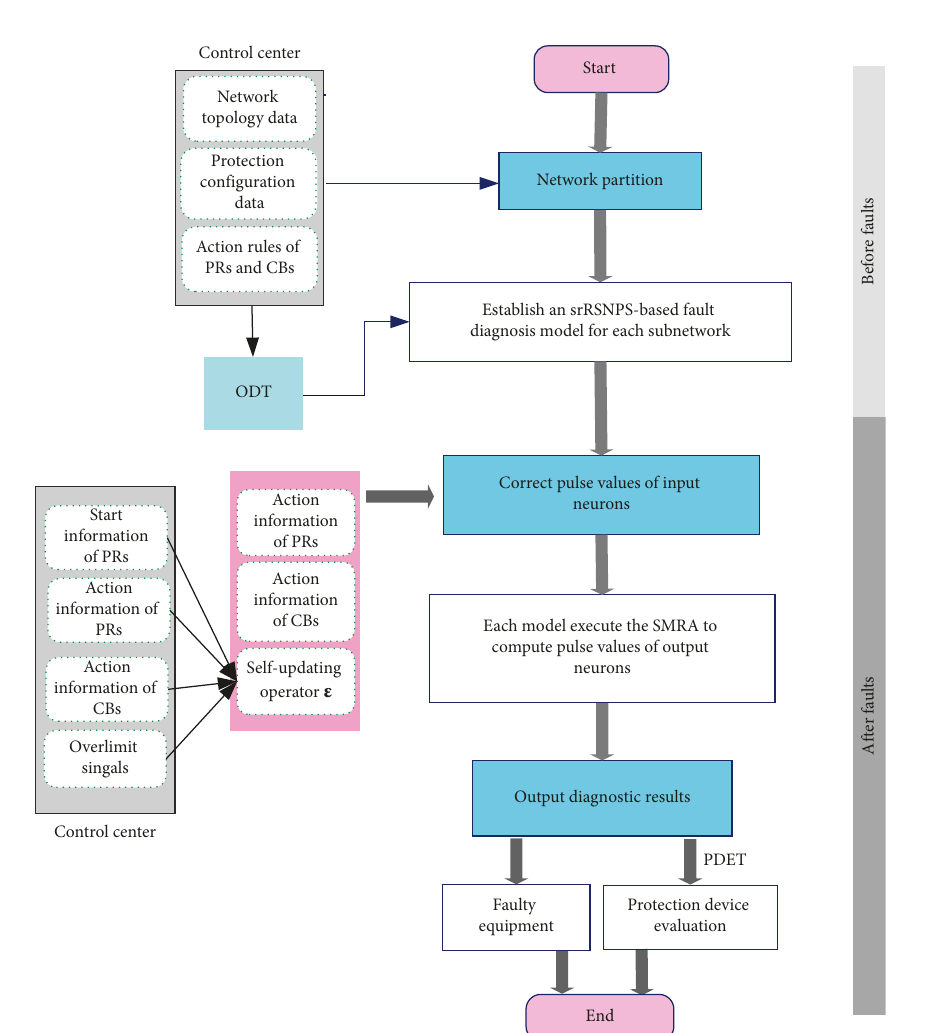
Figure 3: Flowchart of the proposed srSNPS-based fault diagnosis